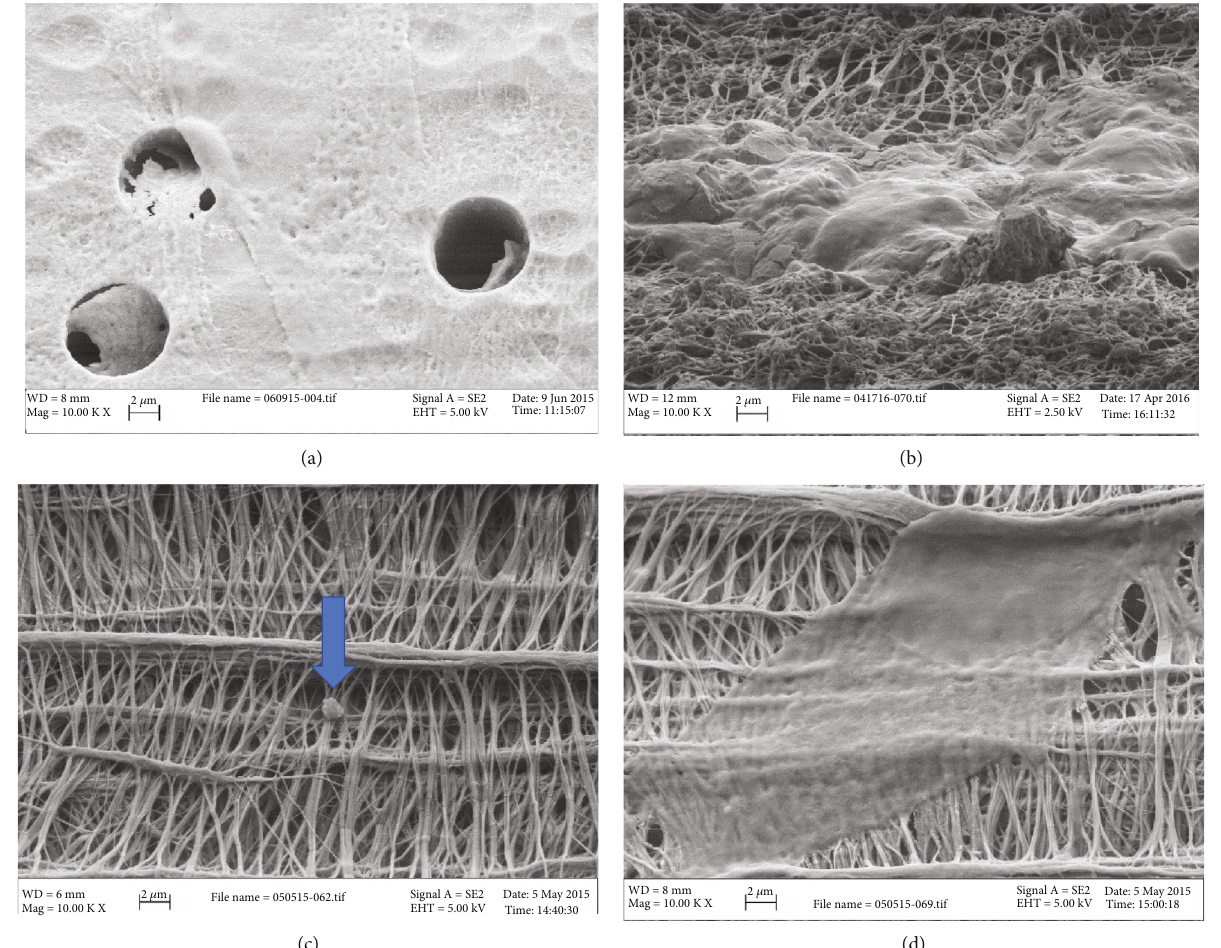
Figure 7: (a) Scanning electron microscope image of migrated GMSCs in the lower compartment of 8-micron pore perforated polycarbonate membrane. (b) Scanning electron microscope image of migrated GMSCs in the lower compartment of 3-micron pore perforated collagen- coated PTFE. (c) Scanning electron microscope image of 0.4-micron pore perforated collagen-coated PTFE showing a GMSC process extending between collagen strands. (d) Scanning electron microscope image of 0.4-micron pore perforated collagen-coated PTFE showing fully migrated